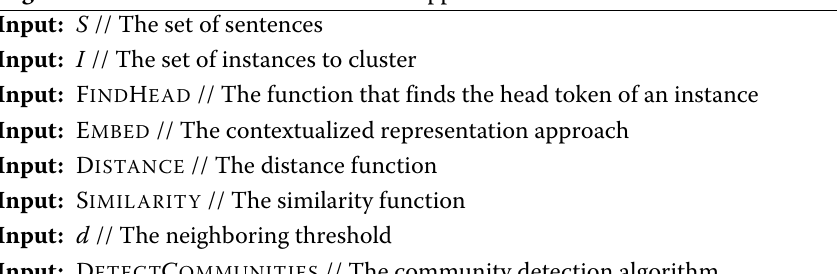
Algorithm 1 Semantic Frame Induction